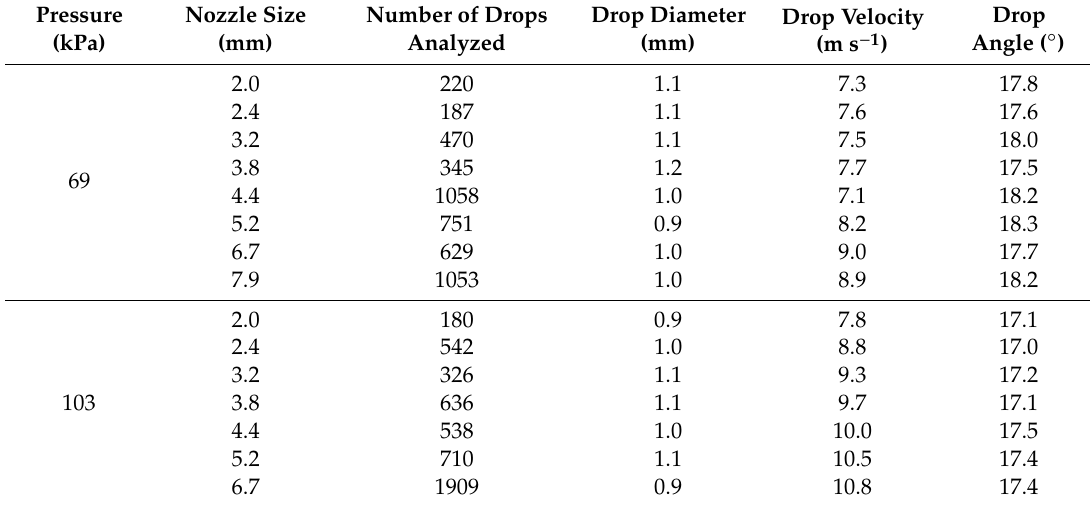
Table 3. Drop features as arithmetic average values defined with the PTV technique after the post-processing for 69 kPa and 103 kPa, and for each of the nozzle sizes